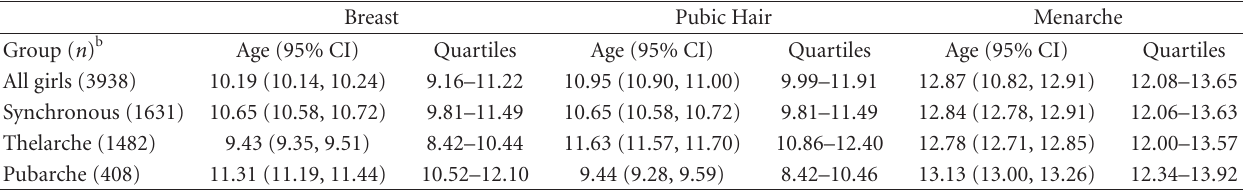
Table 1: Median age a at entry into tanner stage ≥ 2 of breast and pubic hair development and at menarche, overall and by initiation pathway. Breast Pubic Hair Menarche Quartiles Quartiles